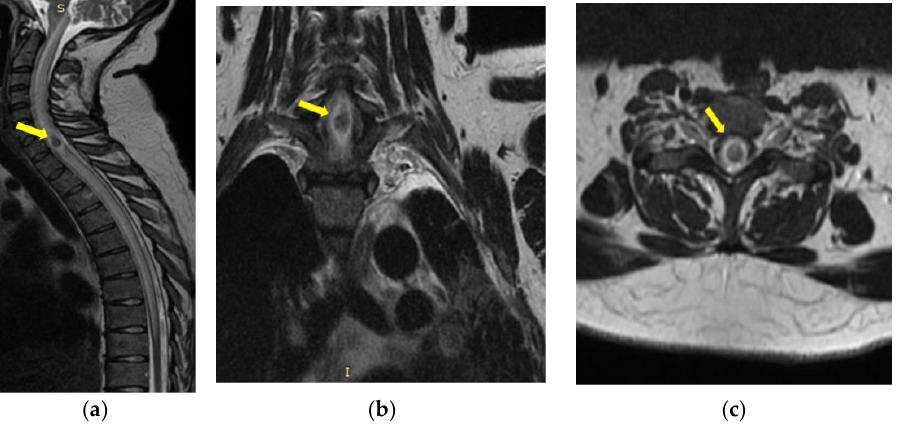
Figure 4. MRI of the cervical spine T2-weighted image—sagittal ( a ), coronal ( b ), and axial ( c ) sections: cord expansion with a decreased signal from abscess core and increased signal from surrounding edema. The yellow arrow indicates the expansive cystic intramedullary process.